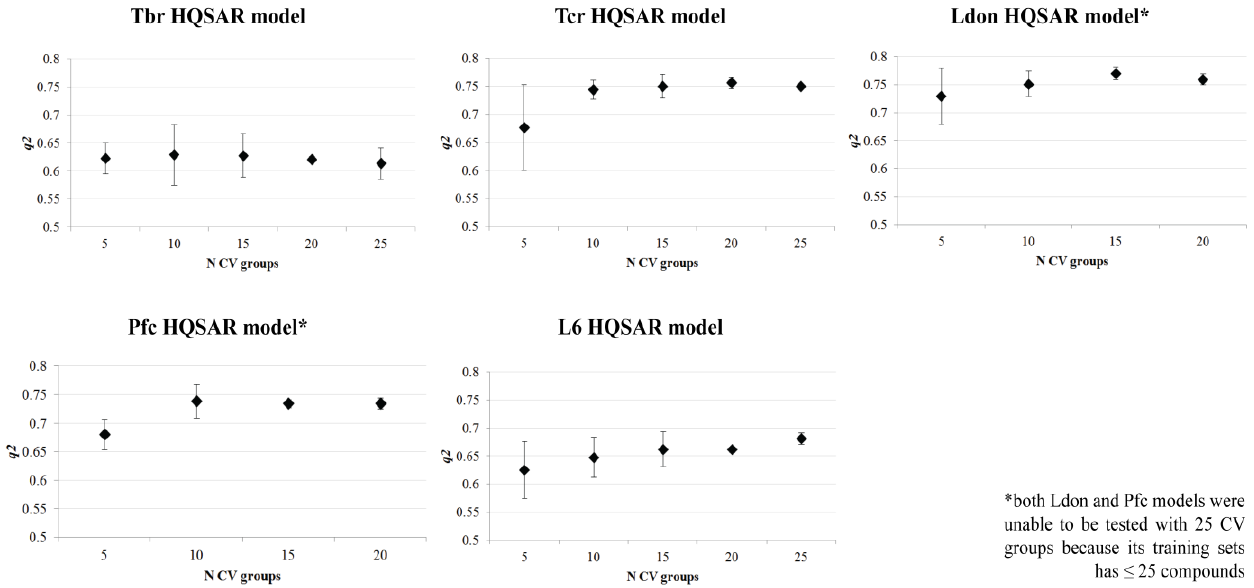
Figure 2. Robustness test of the five constructed HQSAR